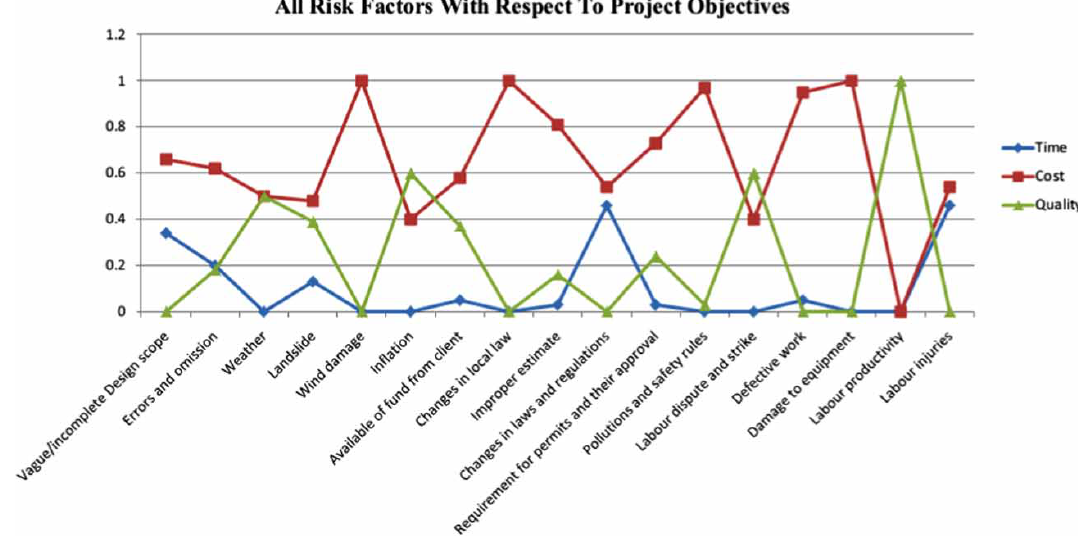
Fig. 5. All risk factors with respect to time, cost, and quality